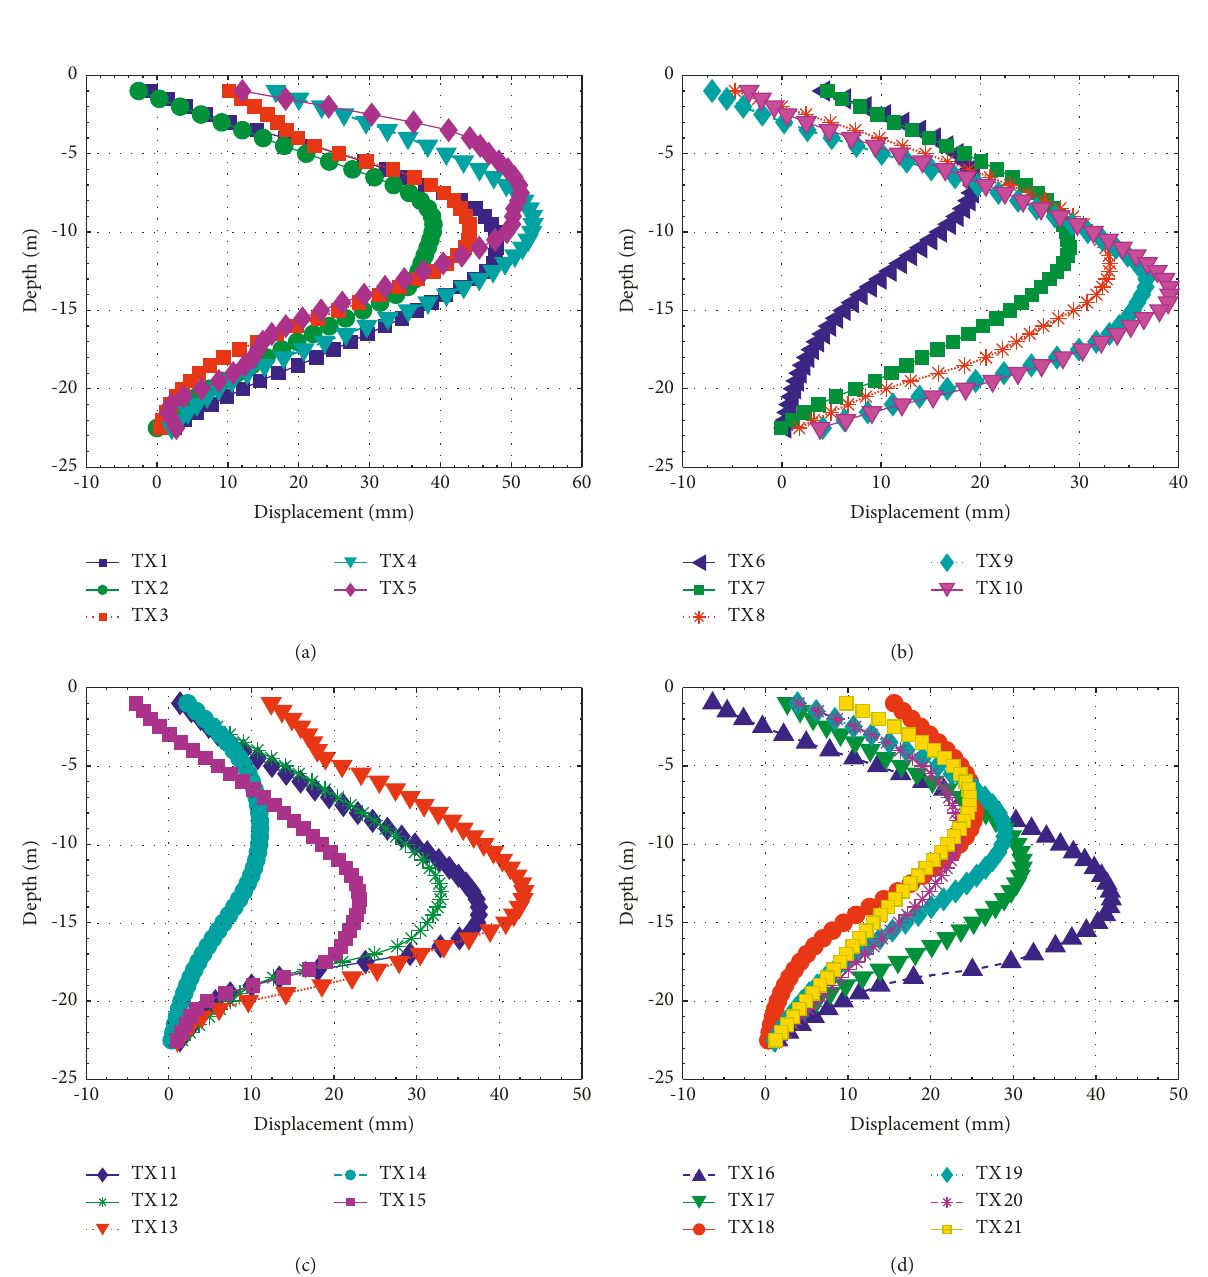
Figure 4: Horizontal displacement of the retained soil in a certain period. (a) Measurement points TX1-TX5. (b) Measurement points TX6- TX10. (c) Measurement points TX11-TX15. (d) Measurement points